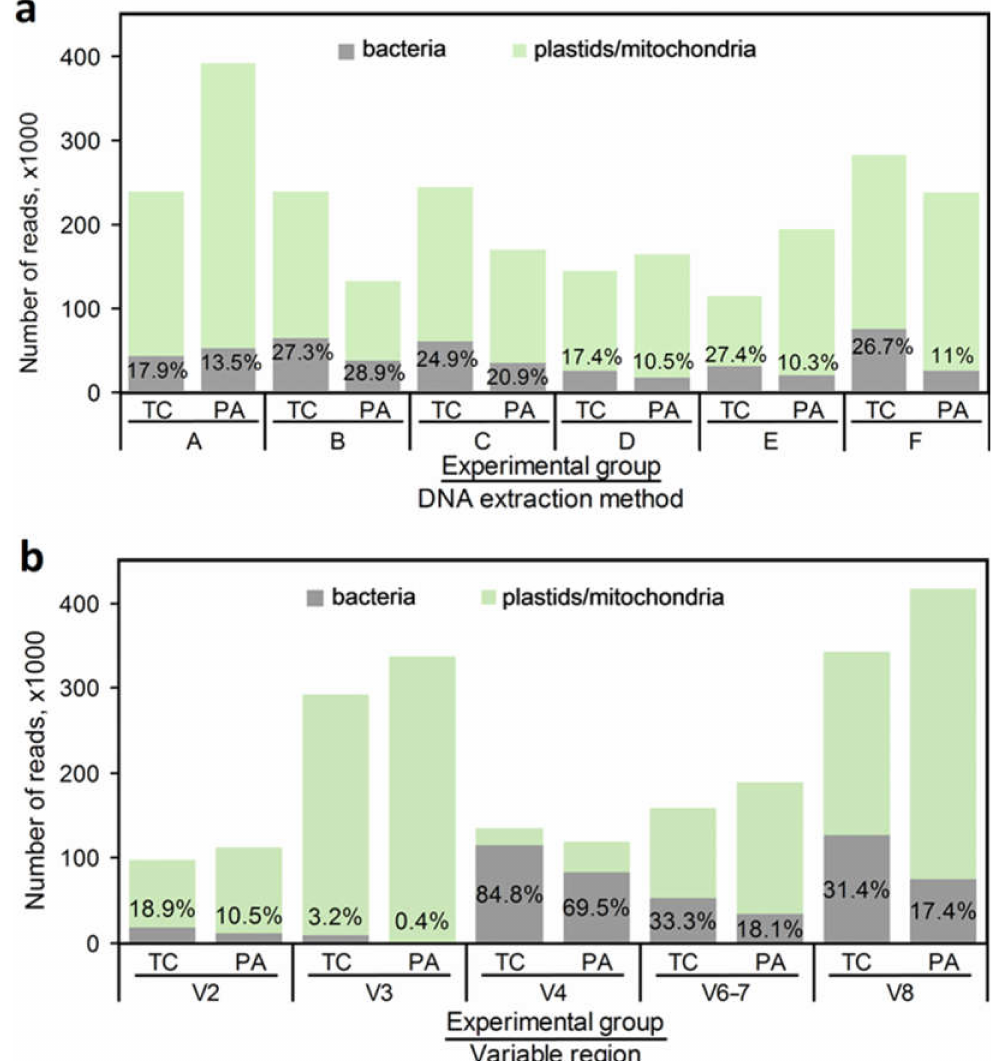
Figure 3. Distribution of the overall number of mapped reads and proportion of bacterial OTUs (blue) to plastid or mitochondrial 16S rRNA sequences (green) generated for the tobacco shoot control (TC) and post-antibiotic treatment (PA) samples using six different DNA extraction and enrichment methods (A—Akinsanya et al., 2015; B—Doyle, 1991; C—Ding et al., 2013; D—PureLink Microbiome DNA Purification Kit (Thermo-Fisher Scientific); E—Li et al., 2001; F—Wang et al., 2008) ( a ) or five primer pairs specific to the V2, V3, V4, V6–7 and V8 variable regions of 16S rRNA gene ( b ). Numbers indicate the percent value of reads mapped to bacterial sequences estimated based on the total number of mapped reads for each individual